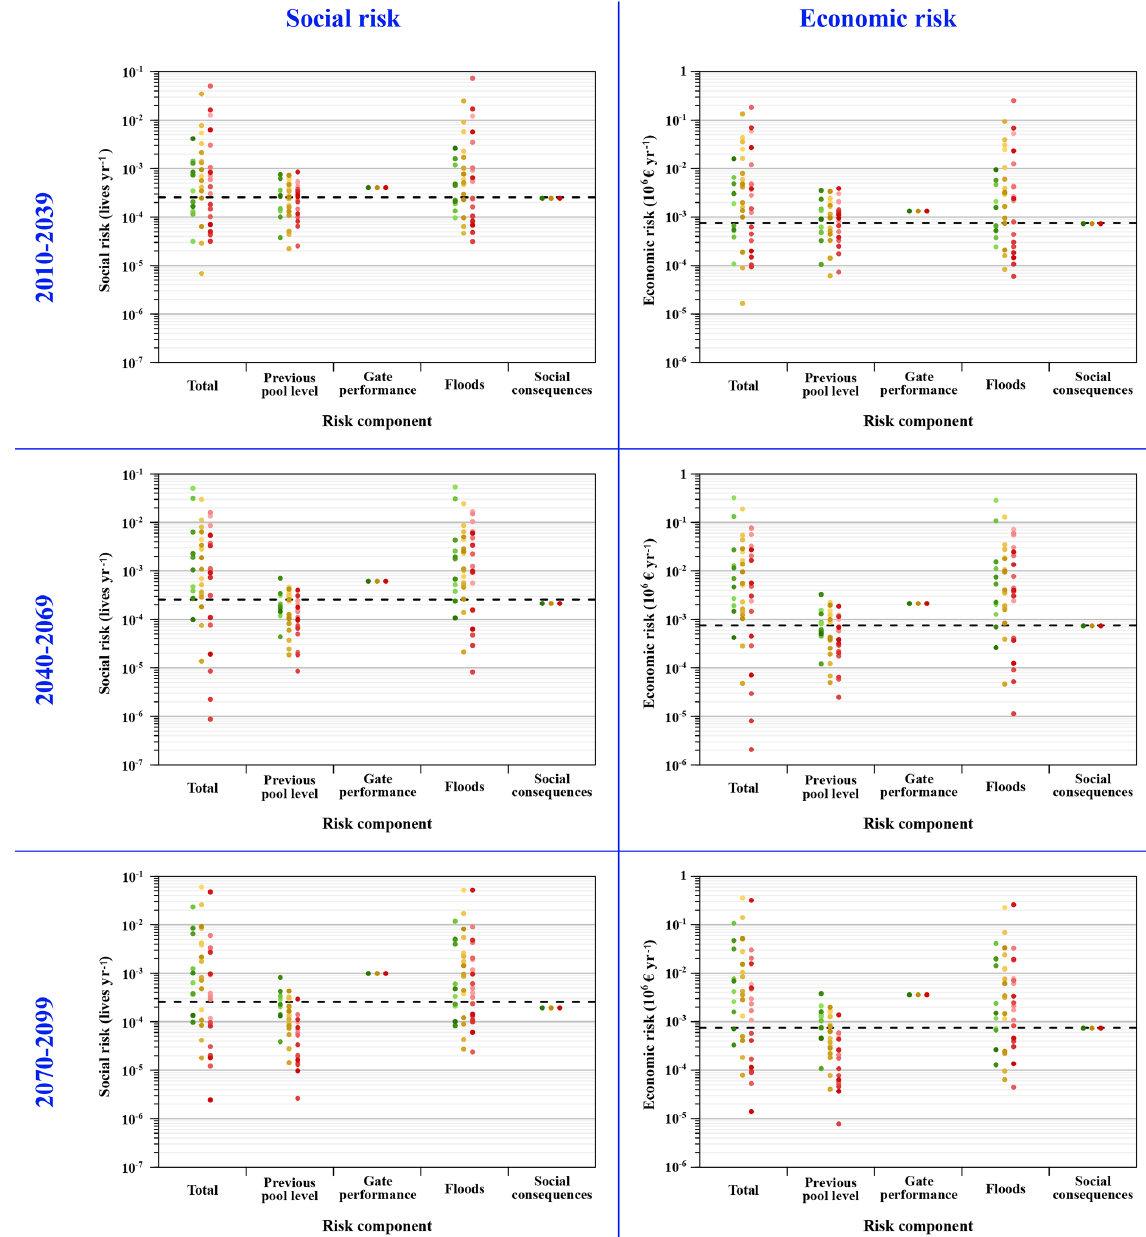
Figure 13. Individual effects of each risk model component on the total social and economic risk computed, classified by period. The same legend as in Fig. 11 is applied here for the points. The base case situation is highlighted with a black dashed